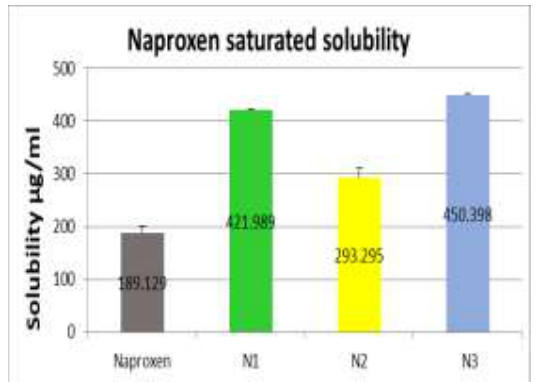
Figure 18. Solubility of pure naproxen and its co-crystals N1, N2 and N3; All values are expressed as mean ±